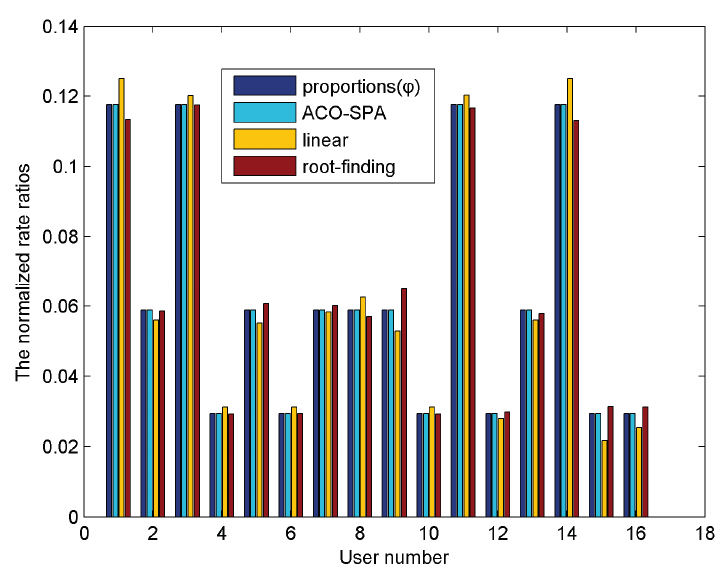
Figure 8. The normalized rate ratios per users.